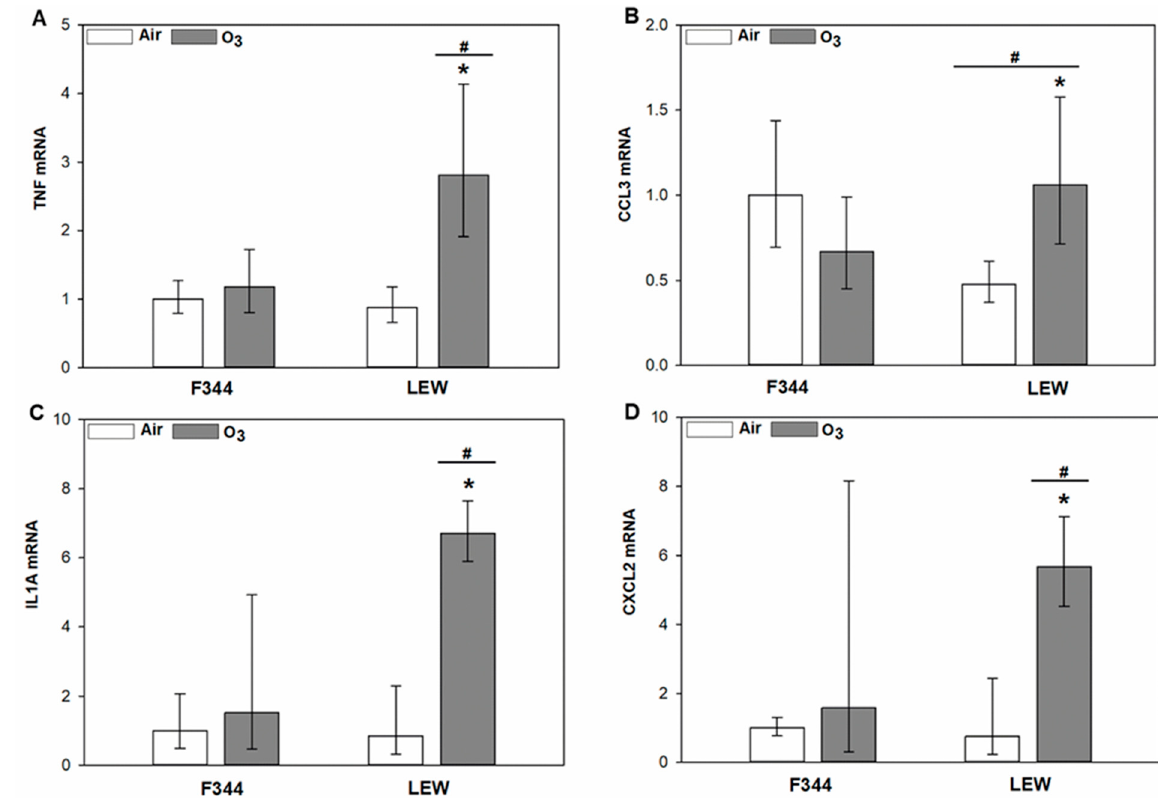
Figure 3. Expression of inflammatory genes in the lungs of Fischer (F344) and Lewis (LEW) rats after exposure to air or 0.8 ppm ozone (O 3 ) for 4 h. Real-time PCR results are expressed as geometric mean of fold-change relative to the F344 air control ± 95% confidence intervals. ( A ). TNF. Ozone x Strain interaction, p < 0.001. ( B ). CCL3. Ozone x Strain interaction, p = 0.001. ( C ). IL1A. Ozone × Strain interaction, p = 0.01. ( D ). CXCL2. Ozone x Strain interaction, p = 0.006. * 0.8 vs. 0 ppm ozone within given strain and # LEW vs. F344 within indicated exposure level (two-way ANOVA followed by Holm–Sidak post-hoc test; n = 4–5 rats).